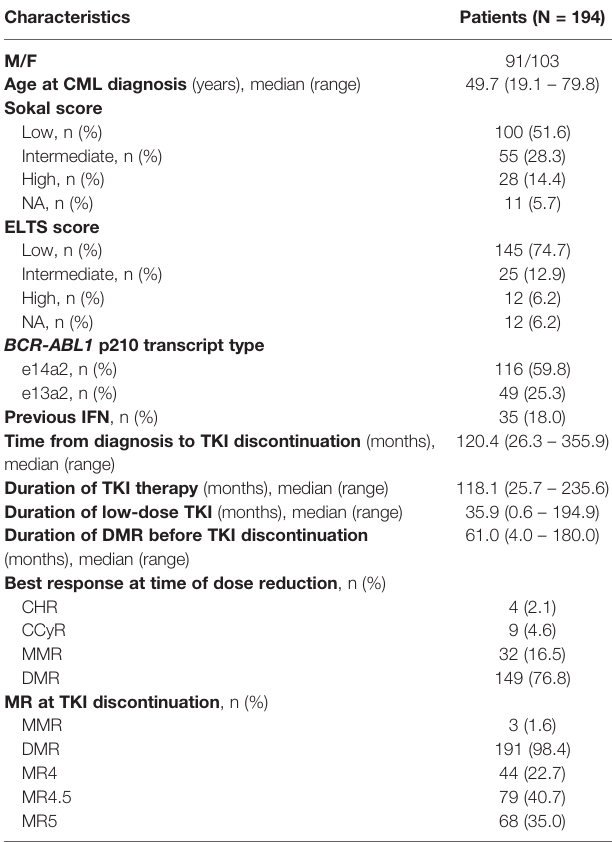
TABLE 1 | Baseline demographics and clinical characteristics of CML patients.